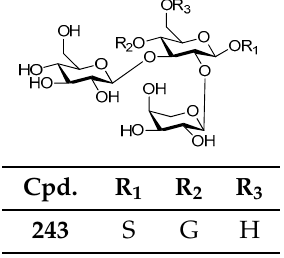
Figure 49. Structure of compound 243 .